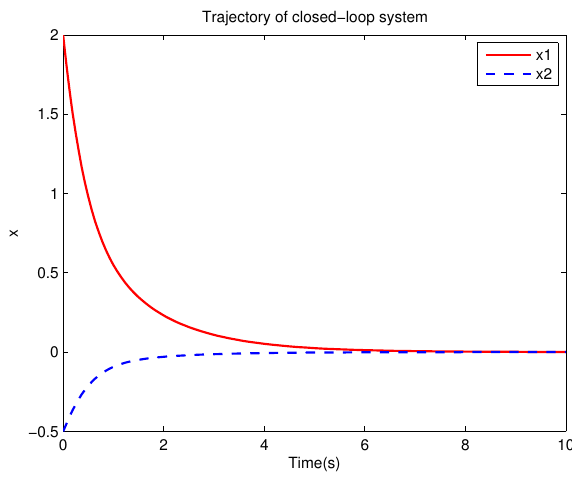
Figure 6. Closed loop system trajectory, p 1 = 2, p 2 =